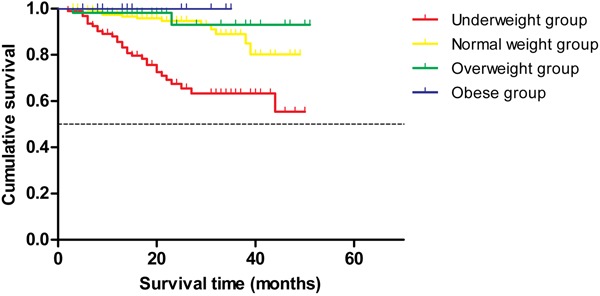
Differences in the cumulative survival curves among the four groups. The
cumulative survival curves were statistically different among the four groups
according to the log-rank test (χ2=31.67, P<0.001). Mortality
gradually increased as BMI decreased according to a trend test
(χ2=35.16, P<0.001).